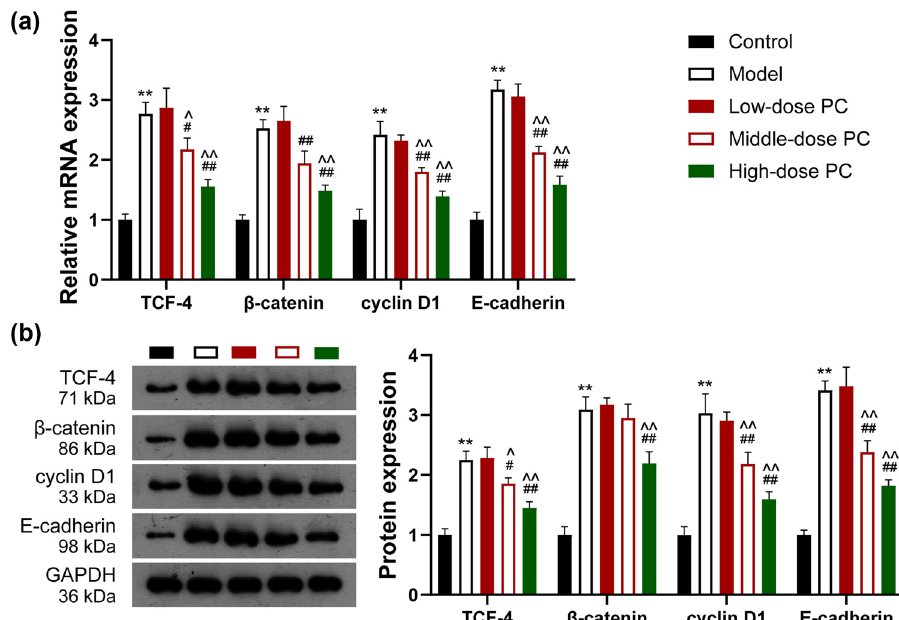
Figure 2: PC inhibits the activation of Wnt/ β - catenin signaling pathway in silicosis rats. ( a ) The mRNA expression of TCF - 4, β - catenin, cyclin D1, and E - cadherin in lung tissues was analyzed by RT - qPCR. ( b ) The protein levels of TCF - 4, β - catenin, cyclin D1, and E - cadherin in lung tissues were analyzed by western blot. ** P < 0.01 vs control, # P < 0.05 and ## P < 0.01 vs model, ^ P < 0.05 and ^^ P < 0.01 vs low - dose